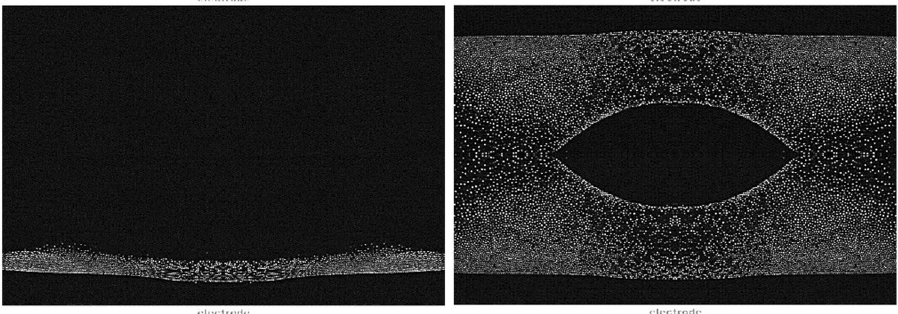
Fig. 2 Complex plasma under gravity (left) and microgravity (right) conditions 82 . The microparticle cloud is compressed by gravity (left), whereas the microparticles under microgravity (right) are distributed in the entire plasma chamber apart from a central